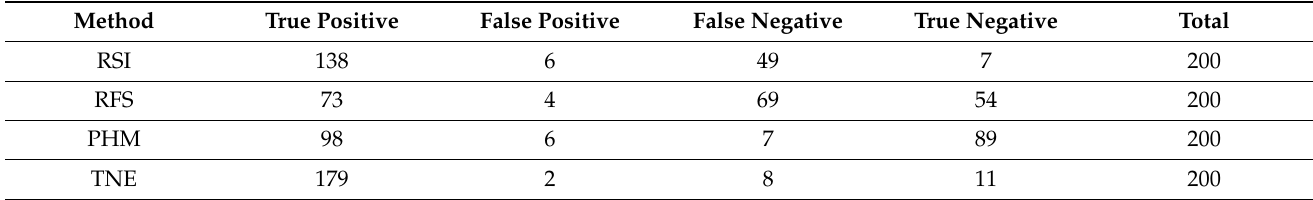
Table 3. Evidence of LPR ( n =